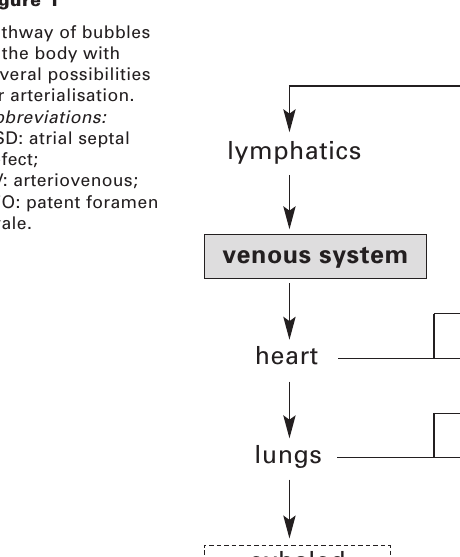
Pathway of bubbles in the body with several possibilities for arterialisation. Abbreviations: ASD: atrial septal defect; AV: arteriovenous; PFO: patent foramen